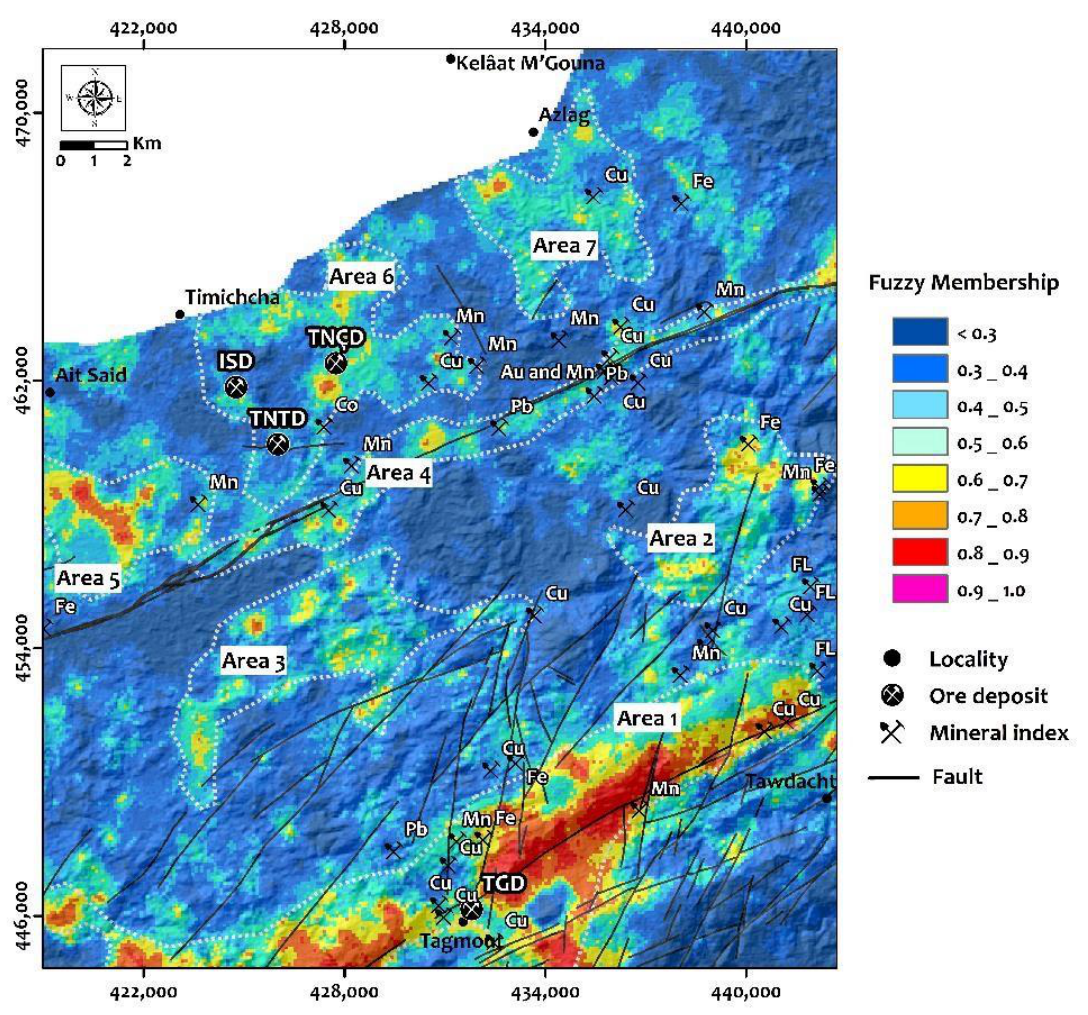
Figure 7. Combination of mineral prospectivity maps.